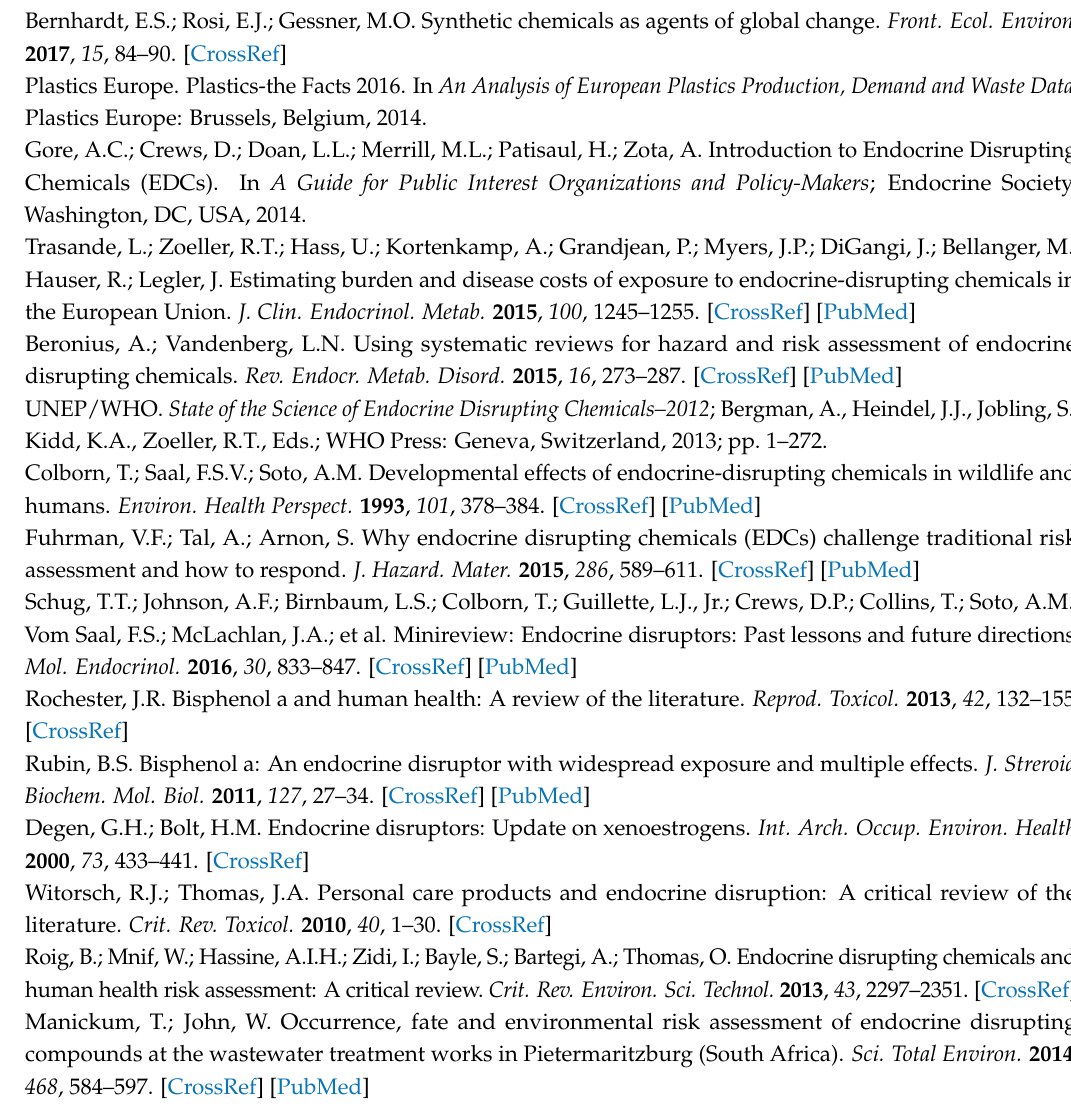
Table S1: Interacting genes and their network types of the 27 related genes between four selected EDCs and ER positive breast cancer based on GeneMANIA network analysis, Table S2: The list of candidate EDCs with the score and their interacting genes curated from CTD, Table S3: The common 27 genes between EDCs and breast cancer, and evidence showing their relation with breast